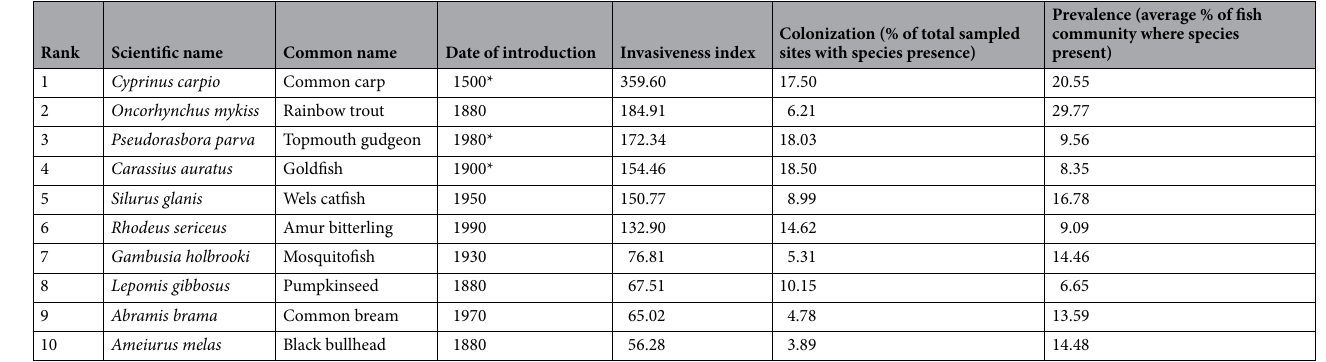
Table 1. Top 10 most invasive species in our dataset, as defined by an invasiveness index resulting from a combination of colonization (% of total sampled sites where present) and prevalence (average relative abundance % where present), and their date of introduction. *Marks uncertain year of